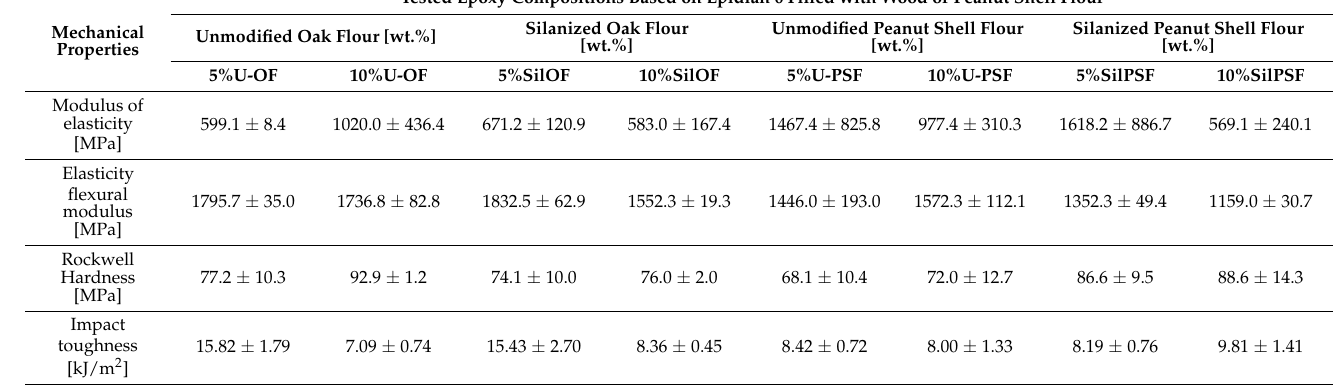
Table 3. Mechanical properties of compositions based on Epidian 6 filled with wood or peanut shell